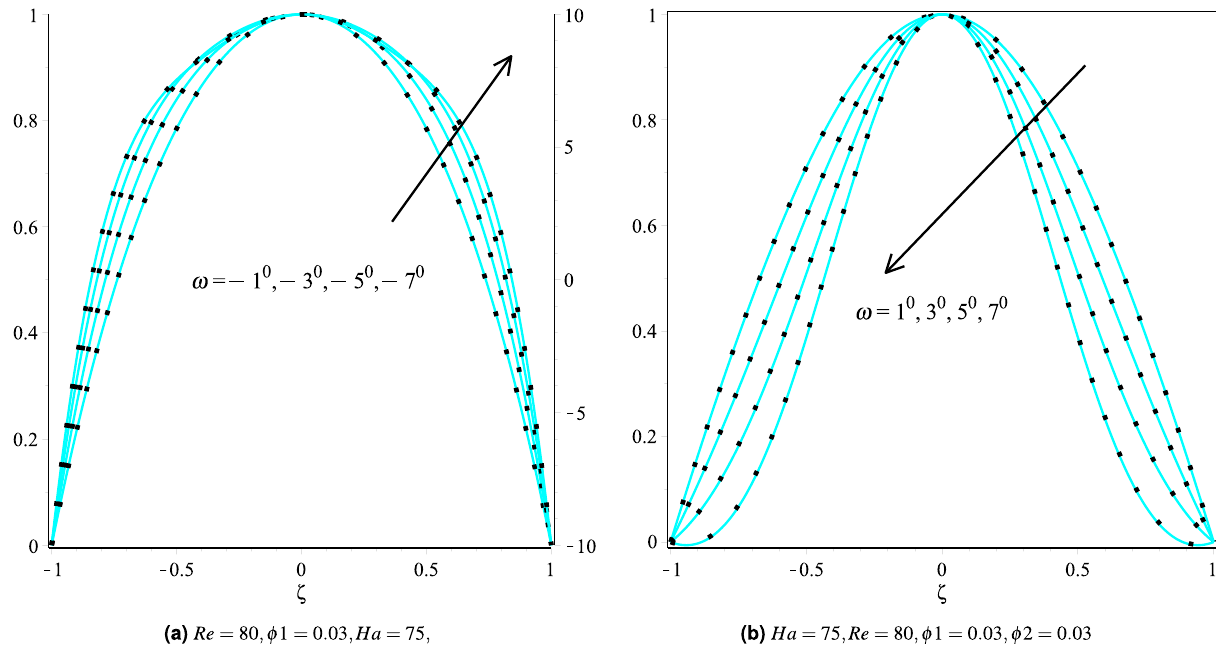
Figure 3. Velocity distribution of the fluid in converging and diverging channel with particular angle for Cu and Cu-Al 2 O 3 /H 2 O, respectively.